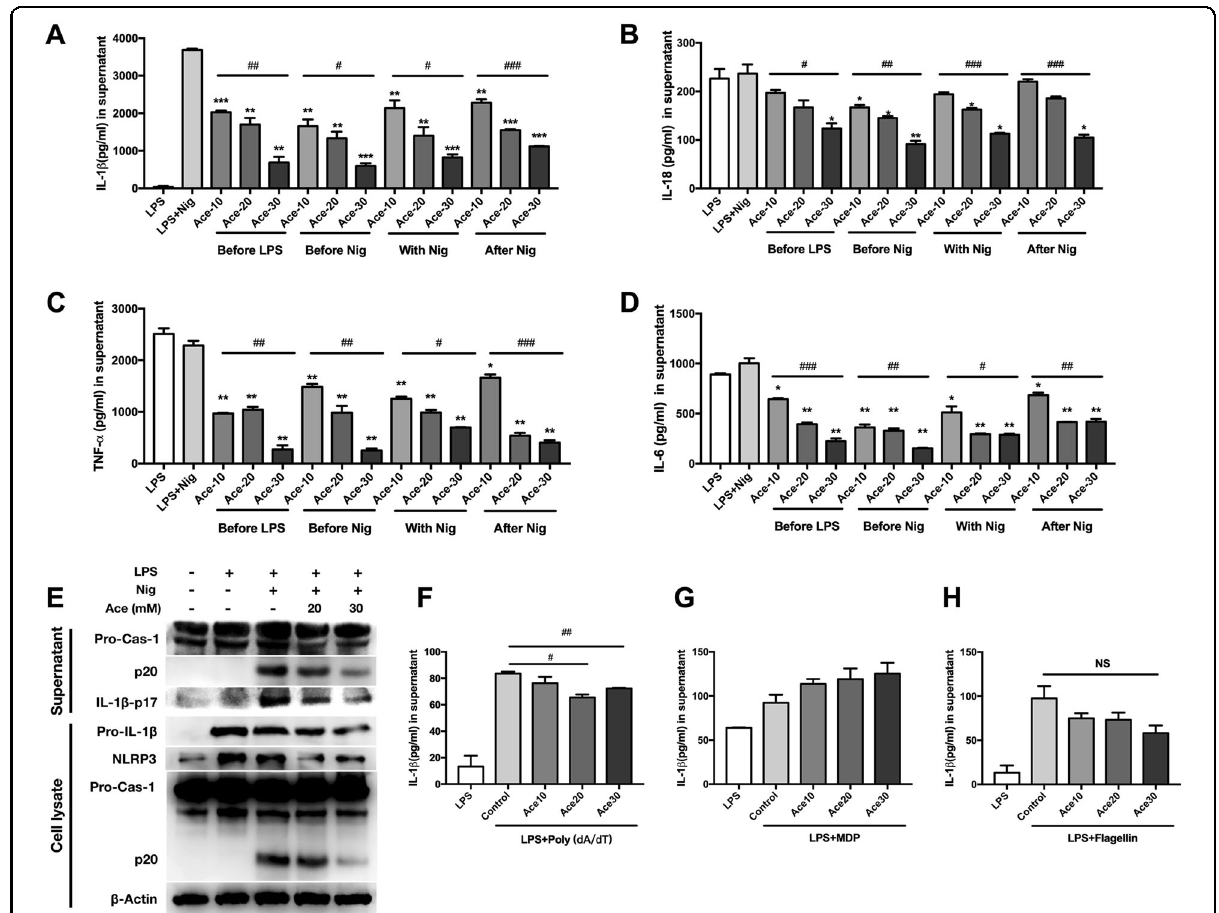
Fig. 2 Acetate suppresses NLRP3 in fl ammasome activation at different time points in vitro. a – d ELISA of IL-1 β ( a ), IL-18 ( b ), TNF- α ( c ), and IL-6 ( d ) production after acetate treatment in BMDMs. Acetate (10, 20, and 30 mM) was administered 30 min before LPS priming, 30 min before nigericin stimulation, simultaneously with nigericin or 30 min after nigericin stimulation. All treatments showed suppressive effects in a dose-dependent manner ( n = 3); * P < 0.05, ** P < 0.01, and *** P < 0.001, Student ’ s t- test compared with the LPS + Nig group; # P < 0.05, ## P < 0.01, and ### P < 0.001, one- way ANOVA for comparison. e Western blot of pro-caspase-1, caspase-1-p20, and IL-1 β -p17 in supernatant and NLRP3, pro-caspase-1, caspase-1-p20 and β -actin in cell lysate after indicated treatment; f – h ELISA of IL-1 β after treatment with poly(dA/dT), MDP and fl agellin ( n = 3). n = biological replicates. Data are presented as the mean ±